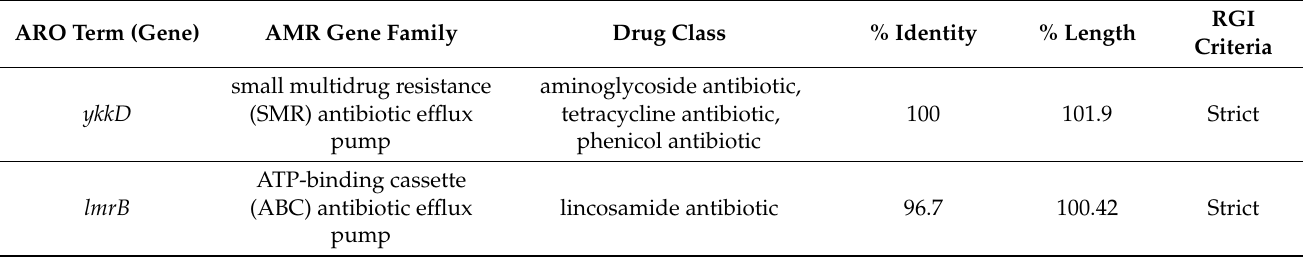
Table 5. Summary of antibiotic resistance genes detected in the BS50 genome using